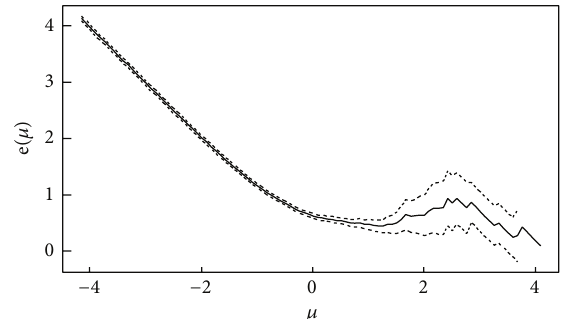
Figure 1: Mean excess plotting for the standardized residual sequence of the loss rate of the Futures Portfolio A. The solid line is the mean excess plotting. The region between the two dotted lines refers to the 95% confidence